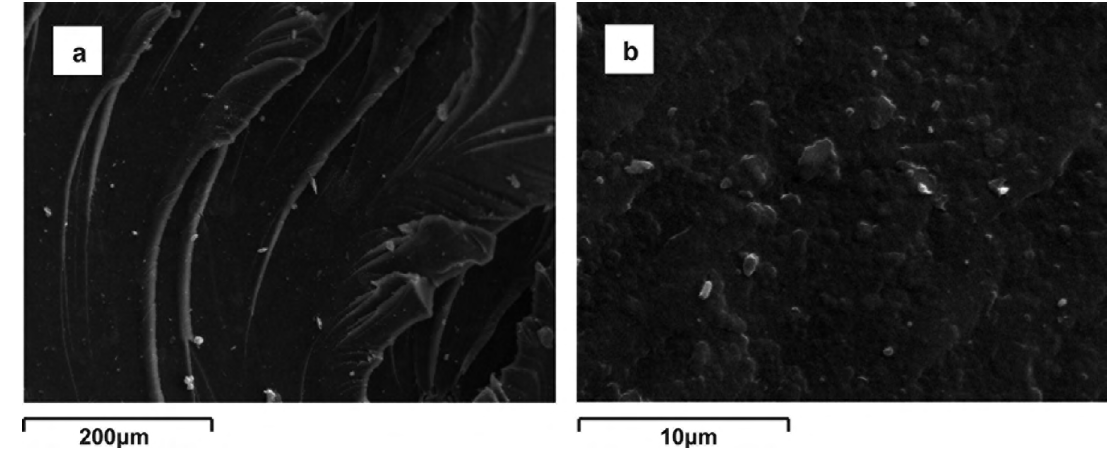
Figure 4. SEM micrographs of: (a) neat epoxy, (b) 25wt% silica nanocomposites